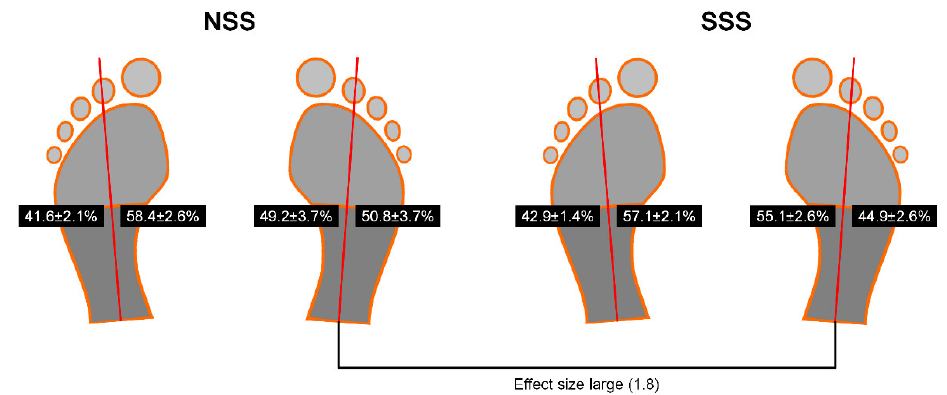
Figure 6. Schematic representation of the medial and lateral percentage of load in the two different shoes. NSS led to an asymmetric loading behavior between the left and right feet, with a higher medial load percentage on the left foot, and a more distributed load percentage between the medial and lateral part of the right foot. By comparison, the SSS led to a more symmetric behavior between the left and right feet, increasing the medial load on the right foot, with similar values with respect to the left foot.